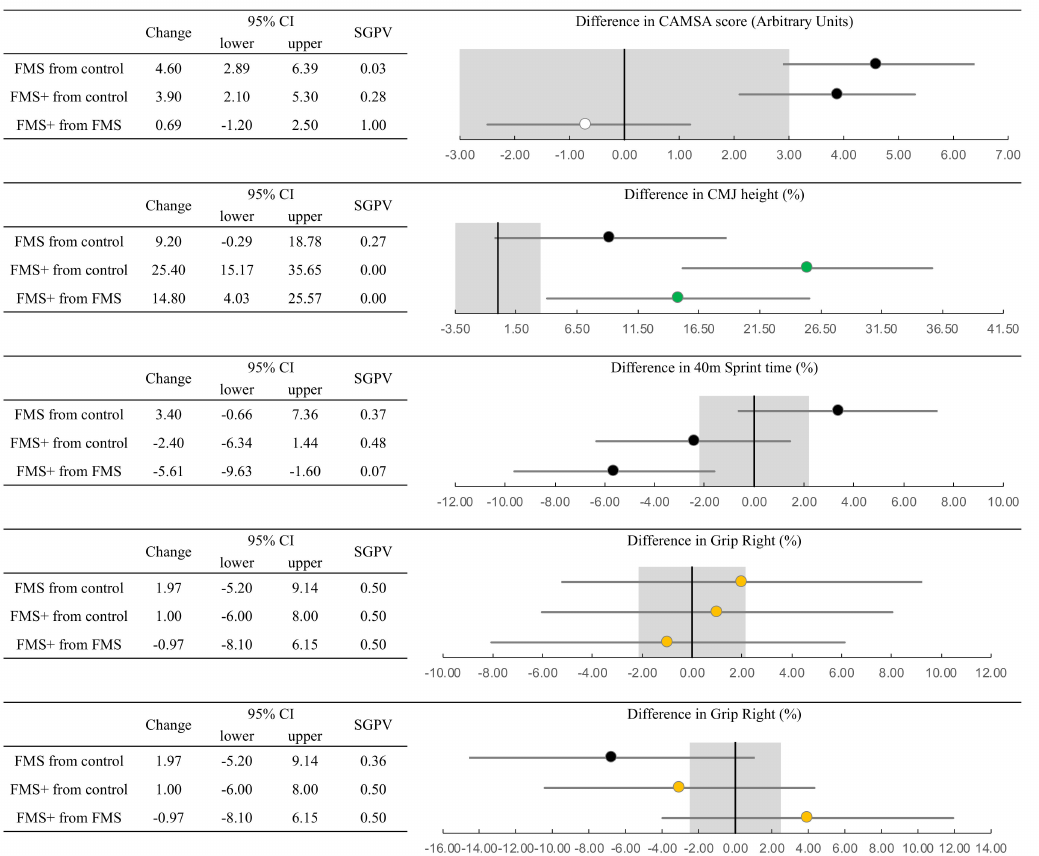
Figure 2. Between-group di ff erences in each outcome measure with 95% confidence intervals (CIs) and second-generation p -value (SGPV). Grey shaded area represents the threshold for a minimal-important di ff erence. Markers highlighted in green represent “conclusive” observations (when the entire 95% CI lies beyond the minimal-important threshold. White markers highlight equivalent observations and amber represent e ff ects that are strictly